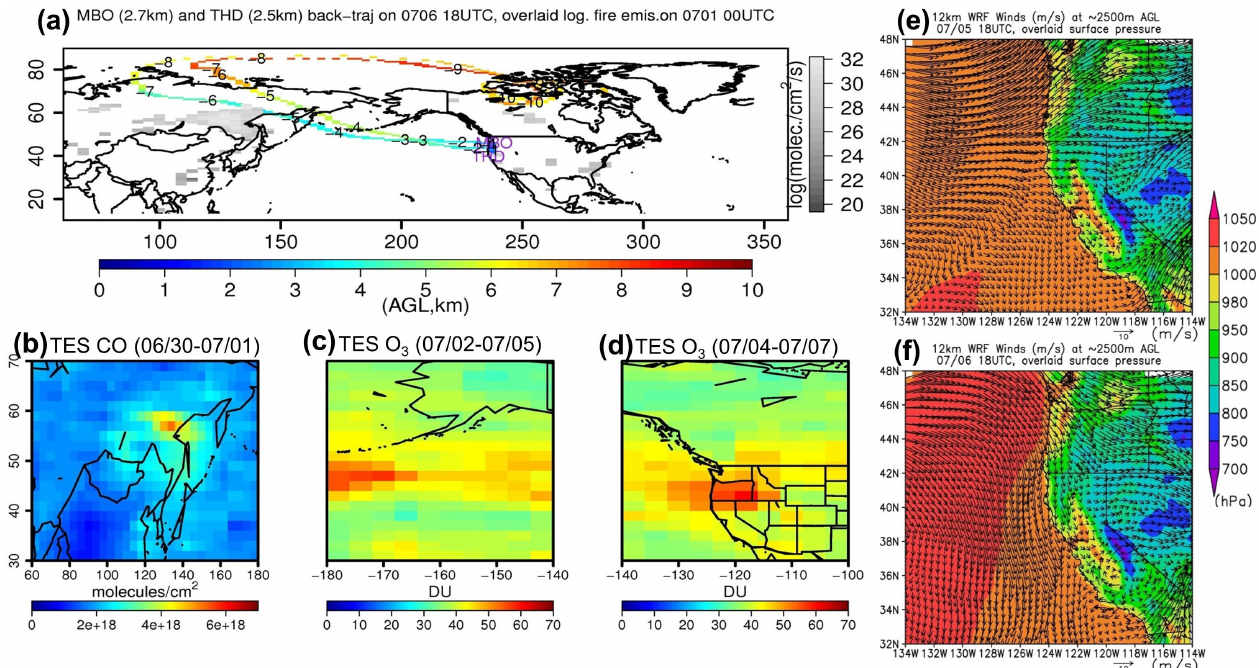
Fig. 10. (a) MBO and THD back-trajectories ending at 18:00UTC on 6 July, colored by the travelling heights (in km, a.g.l.), based on the 60km WRF-simulated wind fields. Negative numbers along the trajectories indicate days back from the ending time. RAQMS fire emissions (log (moleculescm − 2 /s)) at 00:00UTC, 1 July are overlaid with grey color scale. TES Level 3 nadir (b) total CO columns on 30 June–1 July and tropospheric O 3 columns on (c) 2–5 July and (d) 4–7 July. 12km WRF-simulated wind fields ( ∼ 2.5kma.g.l.) overlaid on the surface level pressure (SLP, hPa) at 18:00UTC on (e) 5 July and (f) 6